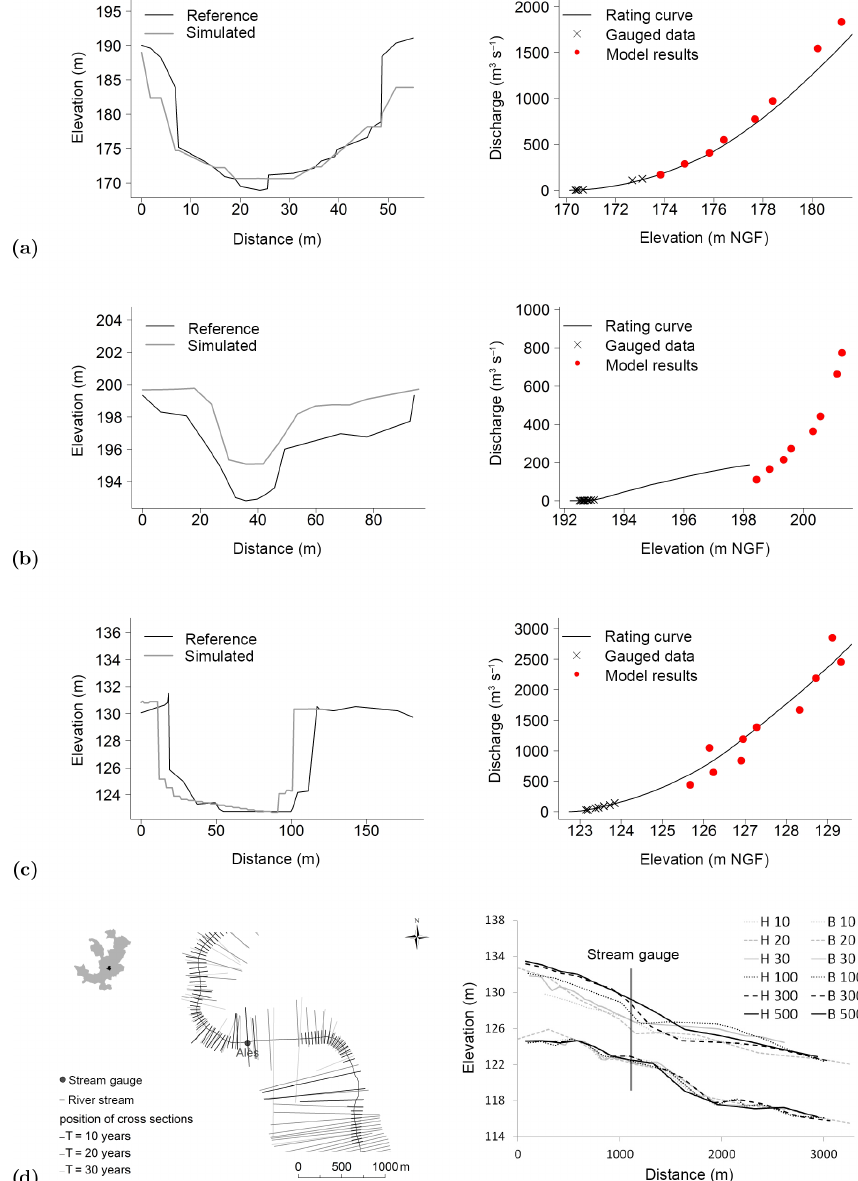
Figure 5. Examples of comparison of cross sections and water levels at three stream gauges: (a) Mialet station, (b) Banne station, (c) Alès station, (d) Alès station: position of cross sections and longitudinal profile of river bed (B) and water levels